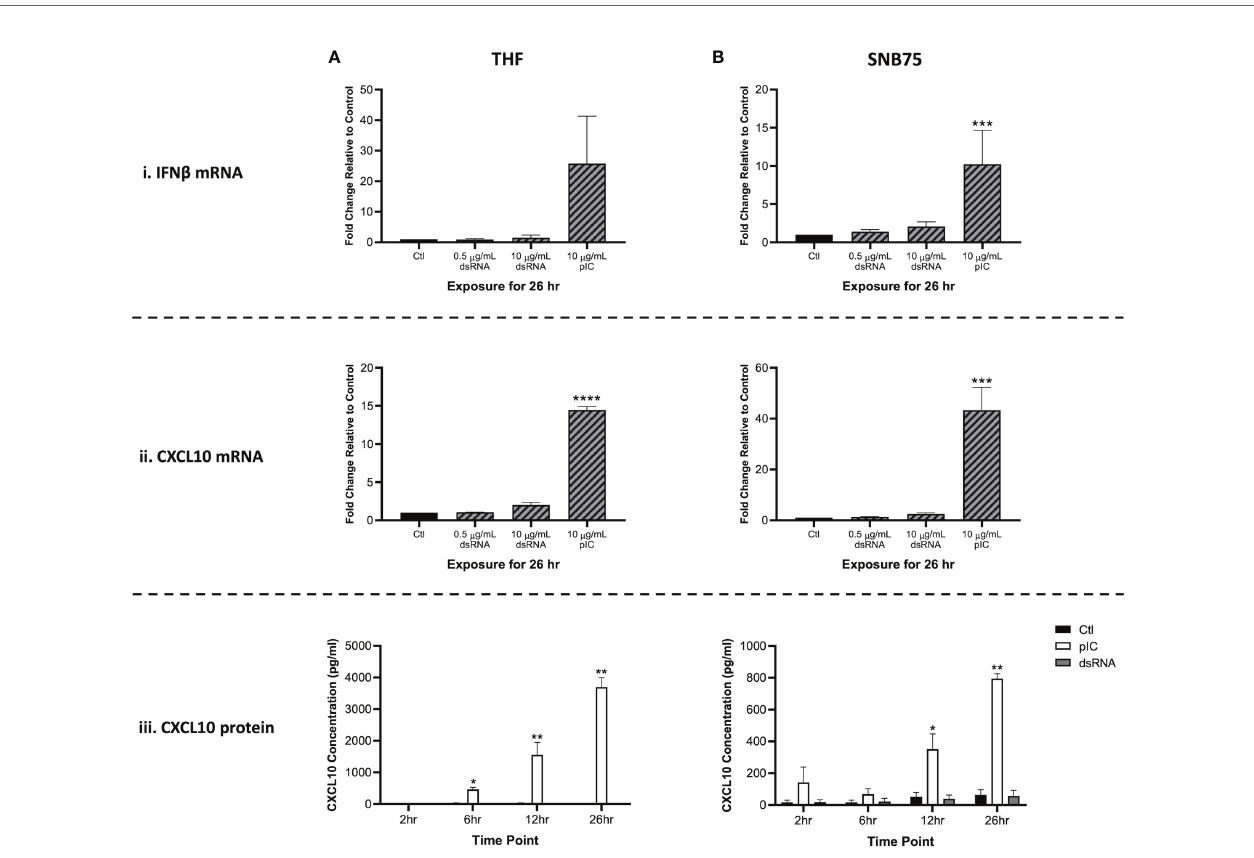
FIGURE 1 | Type I IFN gene expression is not stimulated by soaking cells with low doses of dsRNA. Both THF (A) and SNB75 (B) cells were soaked with 700 bp GFP dsRNA for 26h at concentrations of 0.5 µg/mL and 10 m g/mL as well as with HMW pIC at a concentration of 10 m g/mL. Following treatment, transcript expression of IFN b (i) and CXCL10 (ii) was assessed via qRT-PCR analysis. All data were normalized to the reference gene ( b -Actin) and expressed as a fold change over the control group where control expression was set to 1. A p-value of less than 0.001 is represented by a *** symbol while a p-value of less than 0.0001 is represented by a **** symbol when compared only to the control (Ctl) treatment. A time course experiment was also completed using the THF (A) and SNB75 (B) cells to measure CXCL10 protein production (iii) following 2h, 6h, 12h and 26h of exposure to either 0.5 µg/mL of 700 bp GFP dsRNA, 10 µg/mL of pIC or no stimulation (Ctl). A p-value of less than 0.05 is presented by a * symbol while a p-value of less than 0.01 is presented by a ** symbol. Error bars represent +SEM, and represents the average of 3 independent